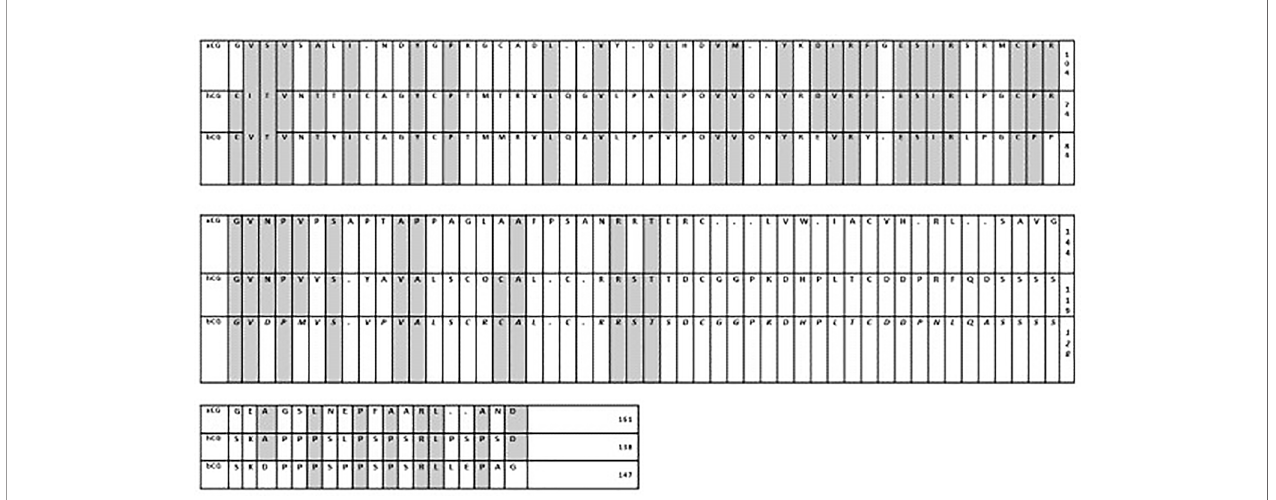
FIGURE 5 | Comparison of alignments of Xanthomonas CG with human CG and baboon CG (46). When Xanthomonas CG was aligned with human CG and baboon CG, there were 46% similarities and 28% identities. xCG, Xanthomonas CG; hCG, human CG; bCG, baboon